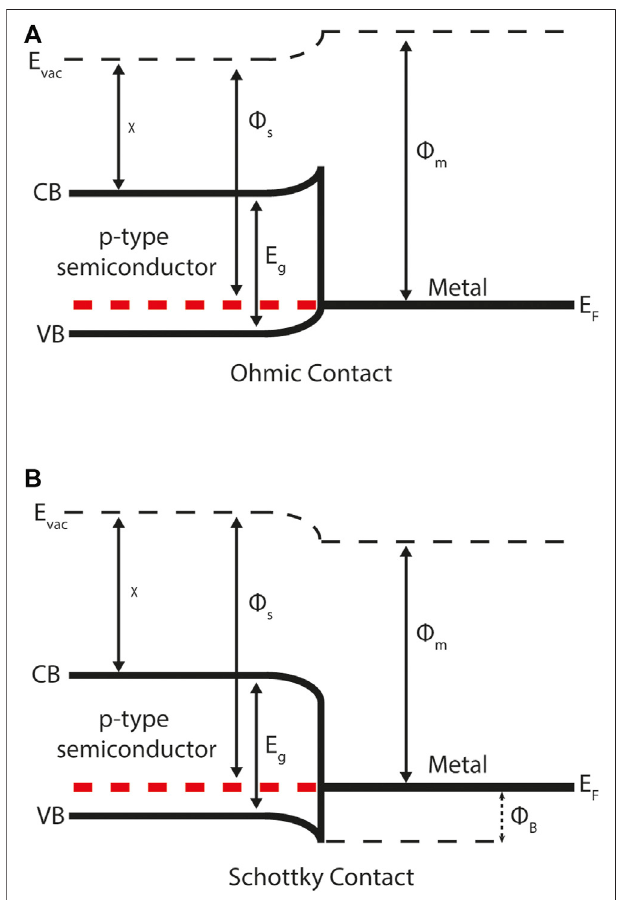
FIGURE 3 | Energy band diagrams for a semiconductor-metal contact demonstrating: (A) ohmic behaviour (B) Schottky behaviour. CB and VB represent the conduction band (minimum) and valance band (maximum) respectively. Φ B describes the Schottky barrier height to majority carrier fl ow (in this case holes) across the junction. The Schottky-Mott rule can be used to calculate Φ B from the metal work function Φ m and semiconductor electron af fi nity χ (both de fi ned relative to the vacuum level E vac ) and semiconductor band gap E g . In equilibrium the Fermi-level E f is constant across the semiconductor-metal